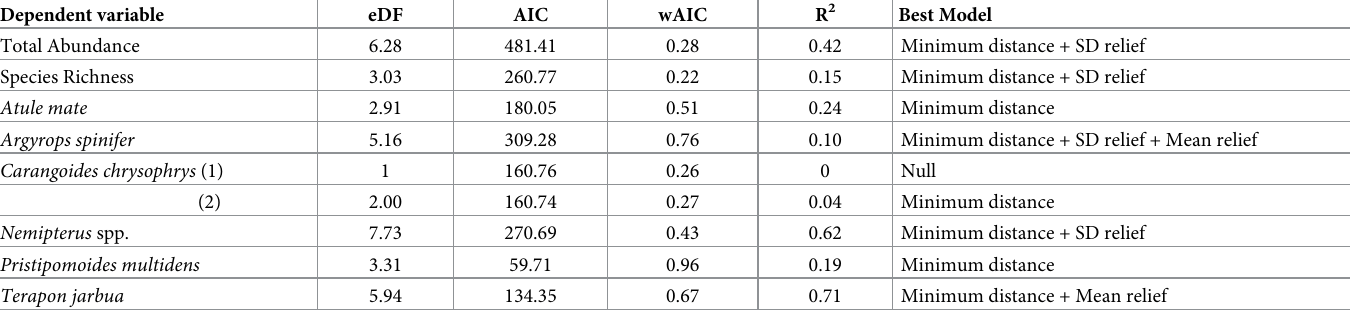
Table 4. Generalised additive models (GAMs) for predicting total abundance, species richness, and the abundance of key species in 40–80 m depth within 2 AIC of the top model. Dependent